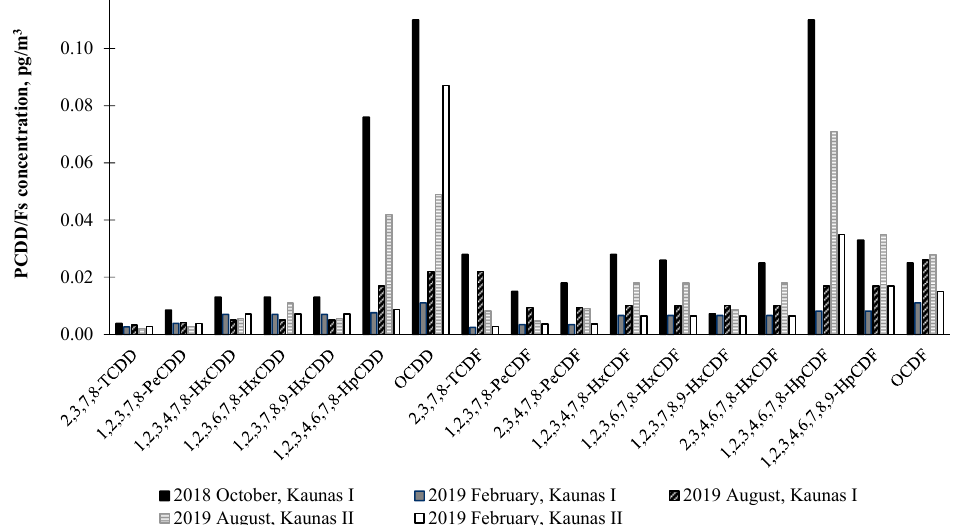
Figure 6. Relative contribution of individual compounds to total PCDD/F concentration measured